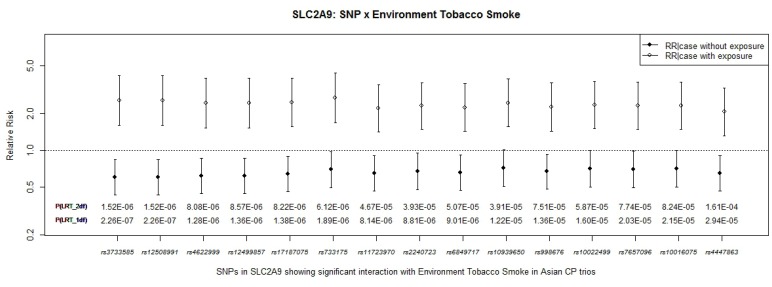
SLC2A9: SNP × Environmental Tobacco Smoke.Estimated RR(CP|G no E) and RR(CP|G and E) from conditional logistic regression model considering SNP effects and their interaction with maternal exposure to ETS on 259 CP case-parent trios of Asian ancestry for fifteen SNPs in SLC2A9. P-values from the 2 df and 1 df LRT for GxE interaction are shown along the X axis.